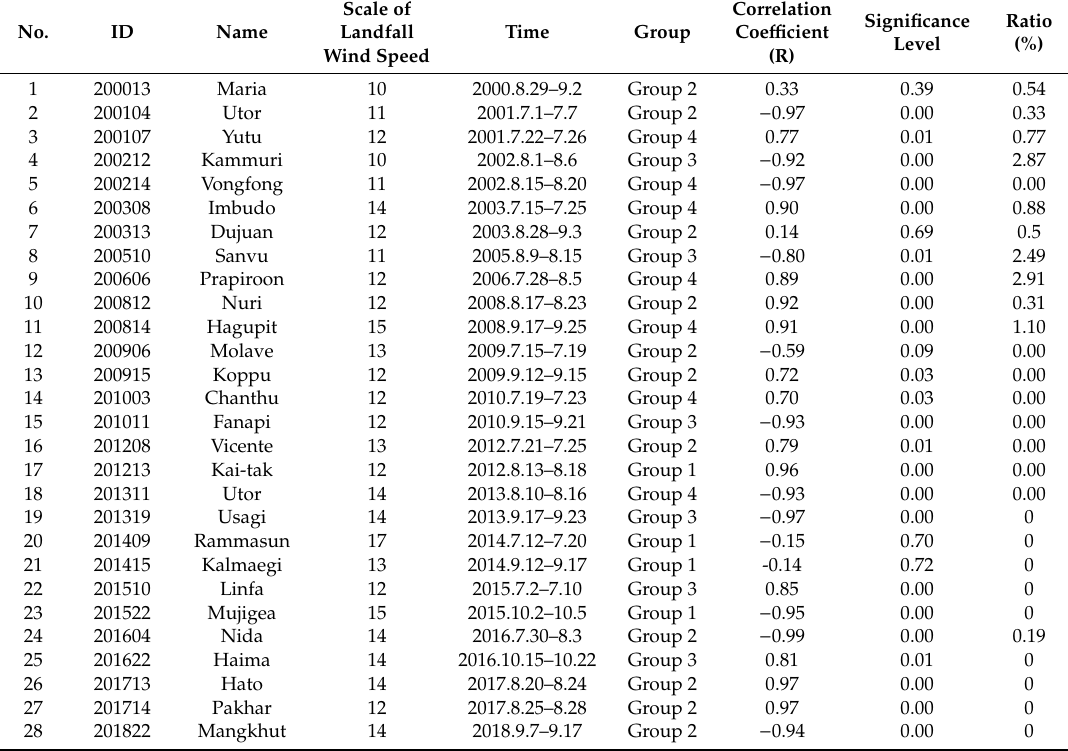
Group 1: The Leizhou Peninsula landfalls group, three typhoons; Group 2: The Pearl River Delta landfalls group, 11 typhoons; Group 3: The Eastern Guangdong landfalls group, seven typhoons; Group 4: The Western Guangdong Landfalls group, seven typhoons.Correlation coe ffi cient ( R ) and Significance level are the results of correlation analysis of elevation levels and area percentages of VD.Ratio is the percentage of pixels with bad quality using